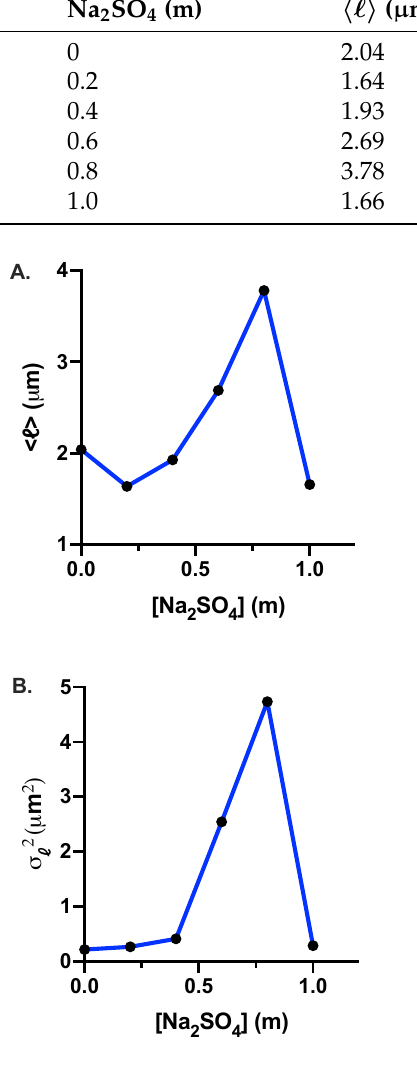
Figure 6. ( A ) Average cell length, (cid:104) (cid:96) (cid:105) , as a function of sodium sulfate concentration. (cid:104) (cid:96) (cid:105) decreases slightly at 0.2 m and 0.4 m, then it increases monotonically between 0.4 m and 0.8 m, and becomes smaller at 1.0 m Na 2 SO 4 . ( B ) Variance of the cell length, σ 2 (cid:96) , as a function of sodium sulfate concentra- tion. The variance increases monotonically with Na 2 SO 4 concentration up to 0.8